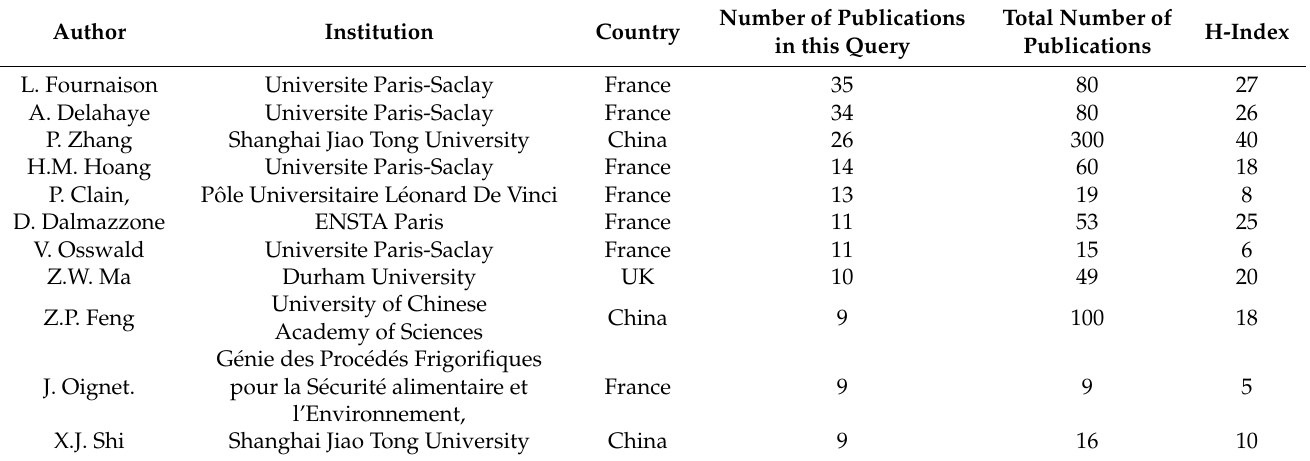
Table 1. List of top authors publishing on the topic.